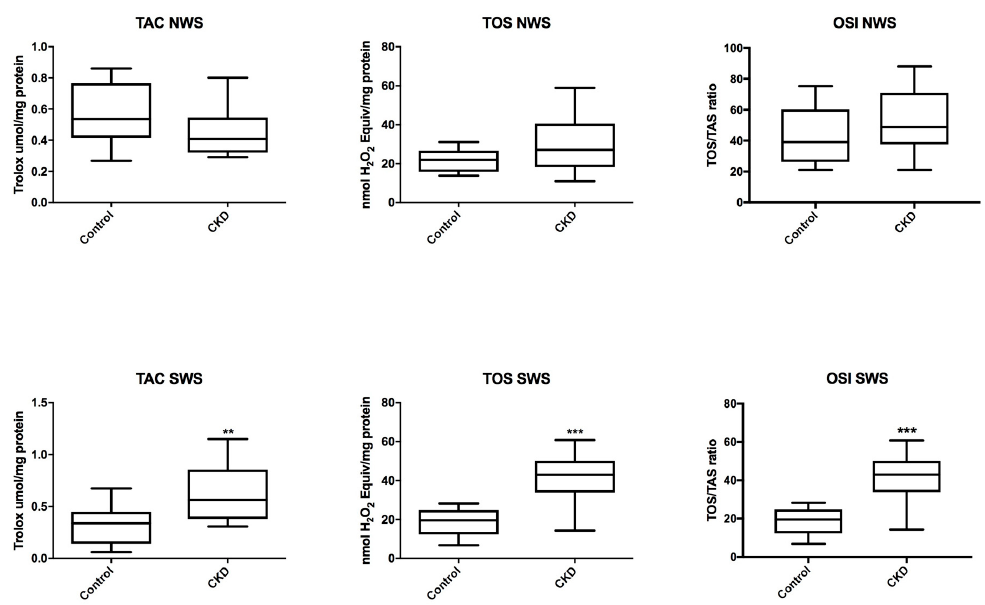
Figure 3. Salivary total antioxidant/oxidant status in children with chronic kidney disease (CKD) and the controls. NWS, non-stimulated whole saliva; OSI, oxidative stress index; SWS, stimulated whole saliva; TAC, total antioxidant capacity; TOS, total oxidative status. Differences statistically important at: ** P < 0.005, *** P < 0.0005.